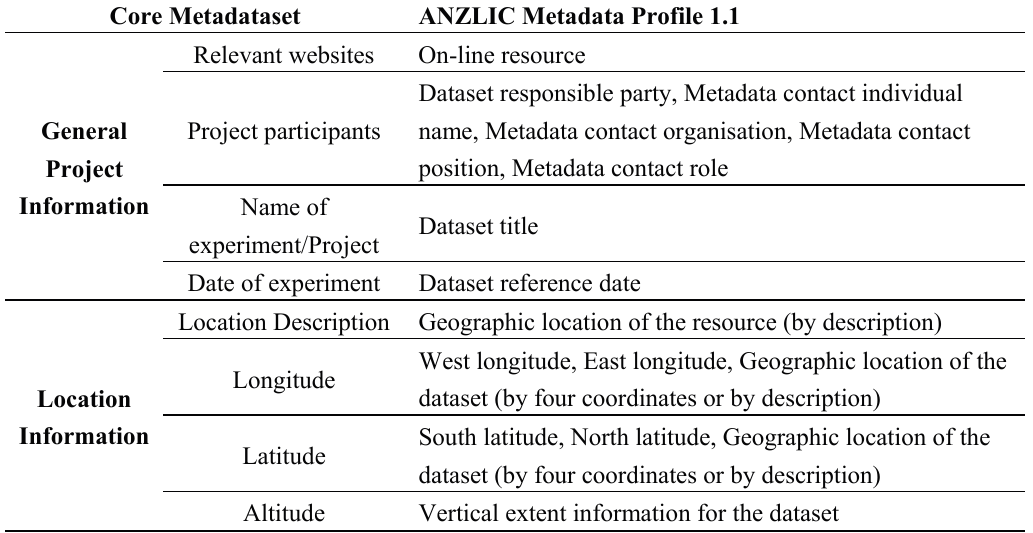
Table A2. Mappings from ANZLIC Metadata Profile 1.1 (Geographic dataset core) to the Core